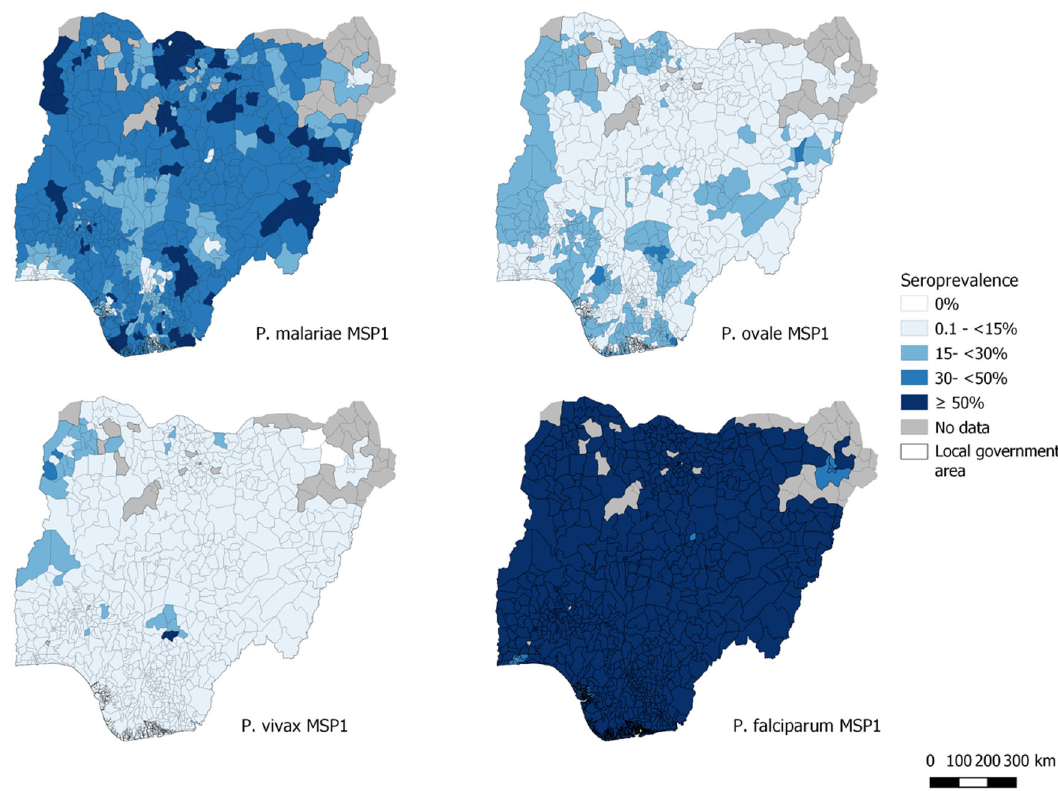
Fig. 3|Seroprevalenceto P.malariae,P.ovale,P.vivax and P.falciparum MSP1 antigensamongchildrenunder15years:Nigeria,2018. Darkershadingindicates higher seroprevalence by local government area (LGA) with gray areas showing